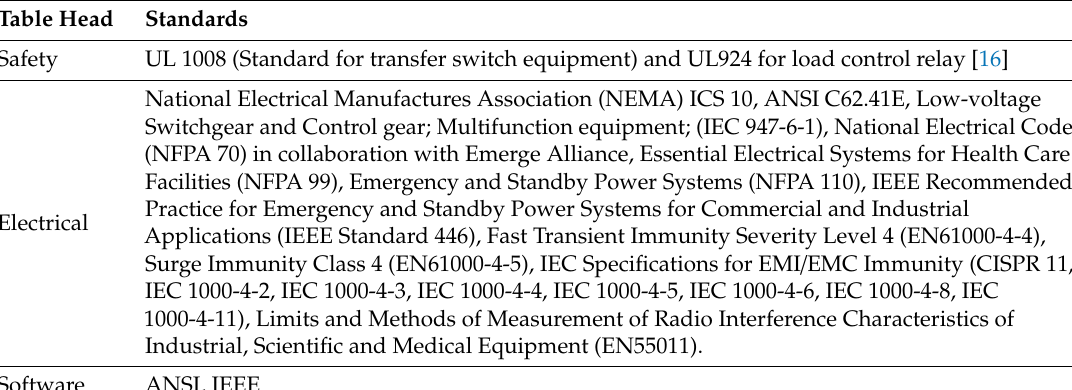
Table 2. Standards in designing the SSTS.